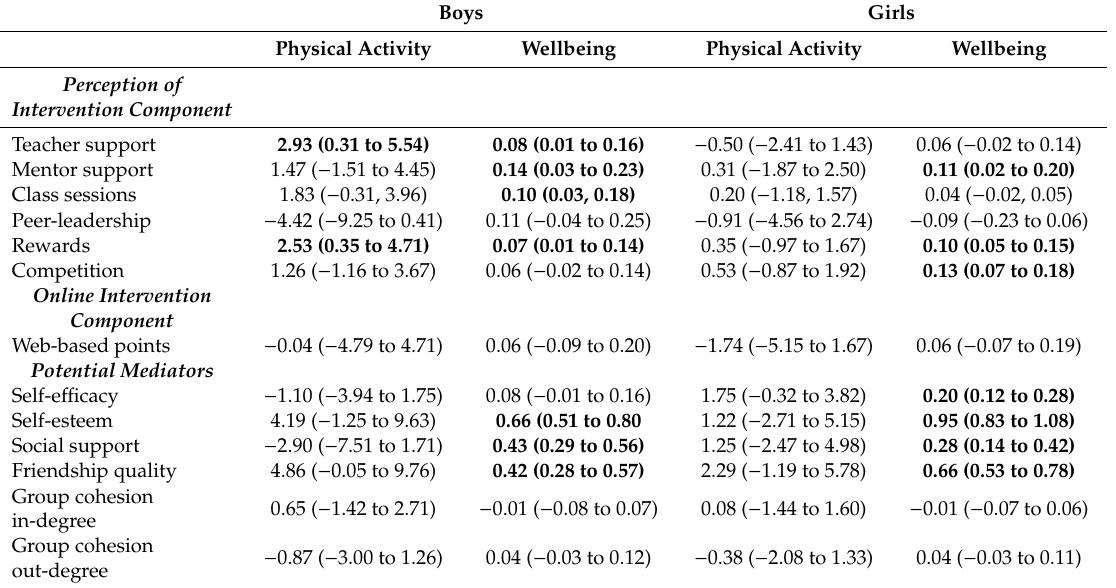
Table 3. Association between intervention components and potential mediators with